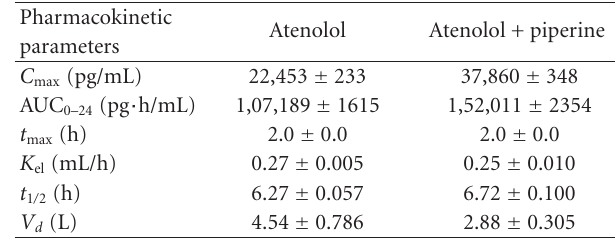
Table 16: Comparison of plasma concentrations ( μ g/mL) of gatifloxacin- and gatifloxacin + piperine-treated birds after single oral administration (10mg/kg) [101].